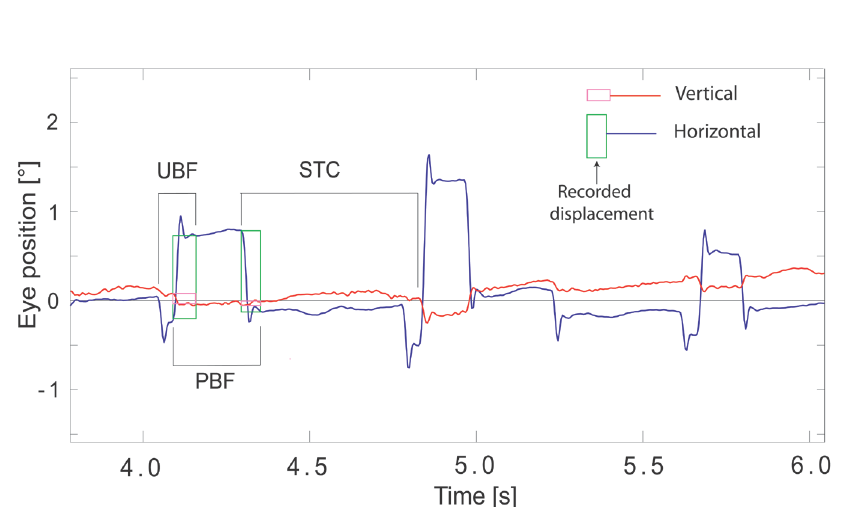
Fig. 1 Example of saccadic